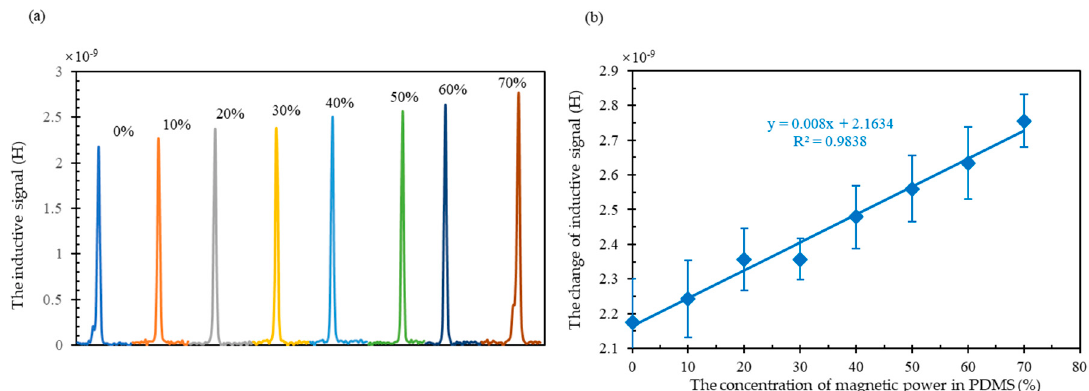
Figure 3. ( a ) the inductive signal (subtract the basic inductance value) for wear debris caused by coil with different concentration of magnetic powder range from 0 to 70%; ( b ) the relationship between the variation of inductive signal and the concentration of magnetic powder.